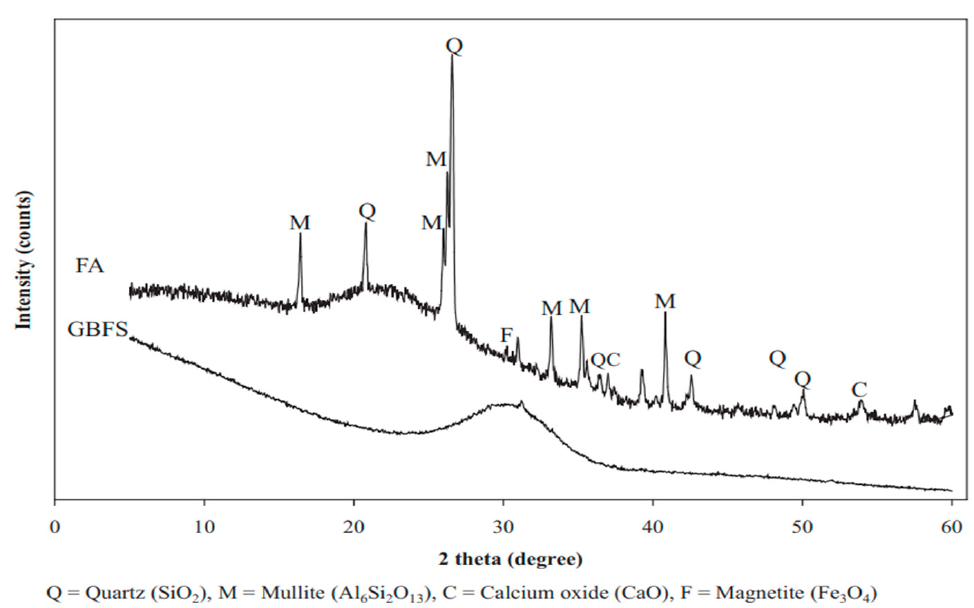
Figure 9. Comparative XRD of GGBFS and FA [105].